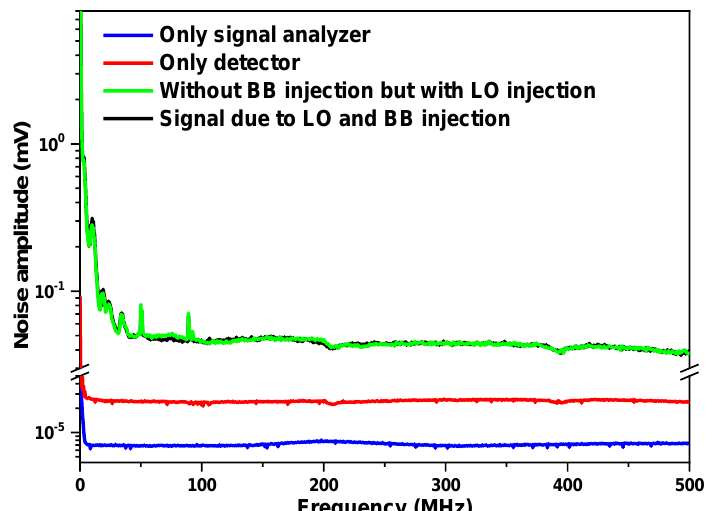
Figure 3. Noise amplitude spectra of the heterodyne system in the bandwidth of 1 kHz – 500 MHz. Comparing the RF output (after the associated amplifier to the photodetector) of the photomixer with both the LO and BB radiation injections (Figure 3, black curve) to that of the photomixer with only the LO injection (Figure 3, green curve), the two signals were almost overlapped, which indicates that there was almost no additional noise contribution from the BB radiation, i.e., signal-induced noise N SIN can be neglected at this stage of